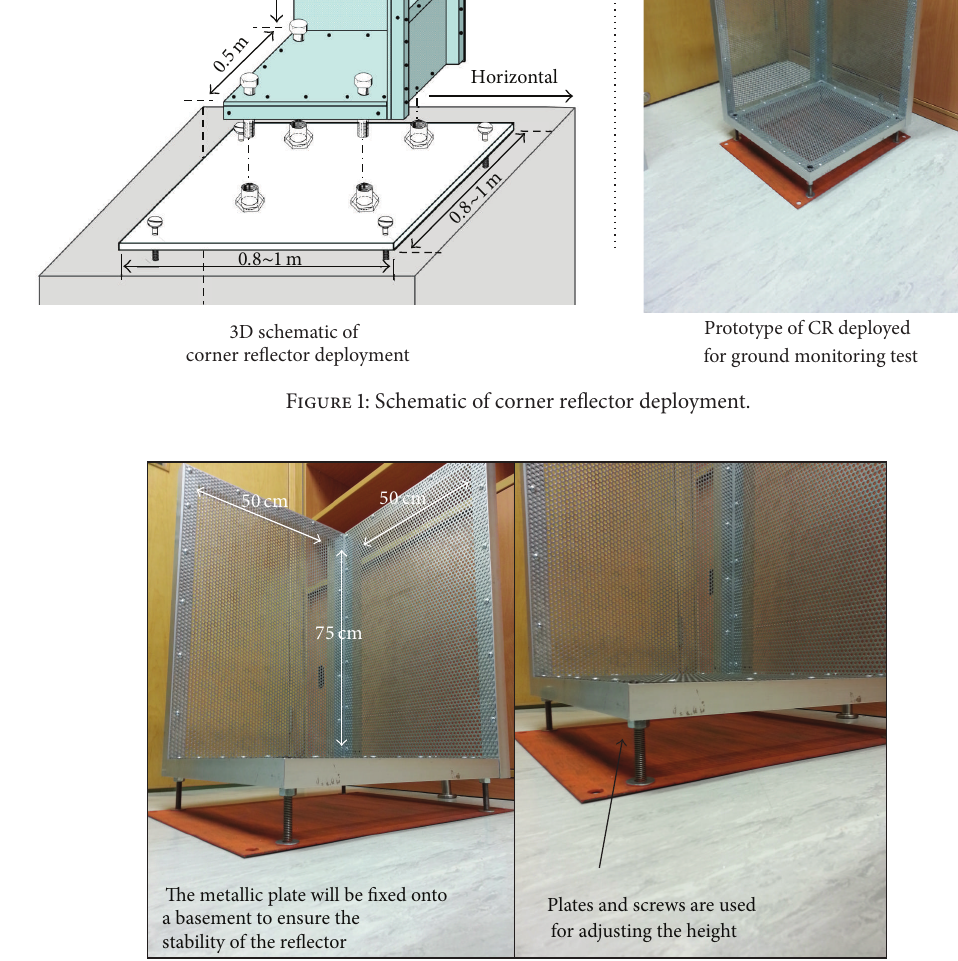
Figure 2: The picture of the reflector.